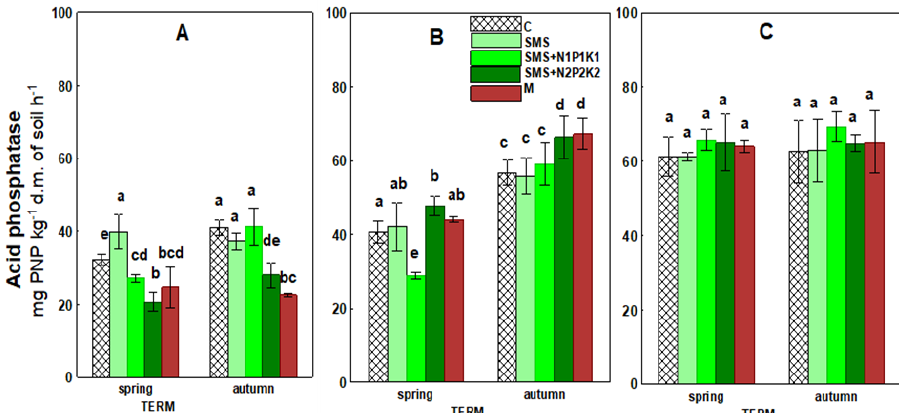
Figure 5. Acid phosphatase activity in control soil and soil under different treatment strategies. ( A )—1st year; ( B )—2nd year; ( C )—3rd year. C—control soil; SMS—soil + spent mushroom substrate; SMS + N1P1K1—soil + spent mushroom substrate + mineral fertilization N1P1K1; SMS + N2P2K2—soil + spent mushroom substrate + mineral fertilization N2P2K2; M—soil + manure. The vertical lines indicate the standard deviation. Different letters above the columns indicate significant differences at